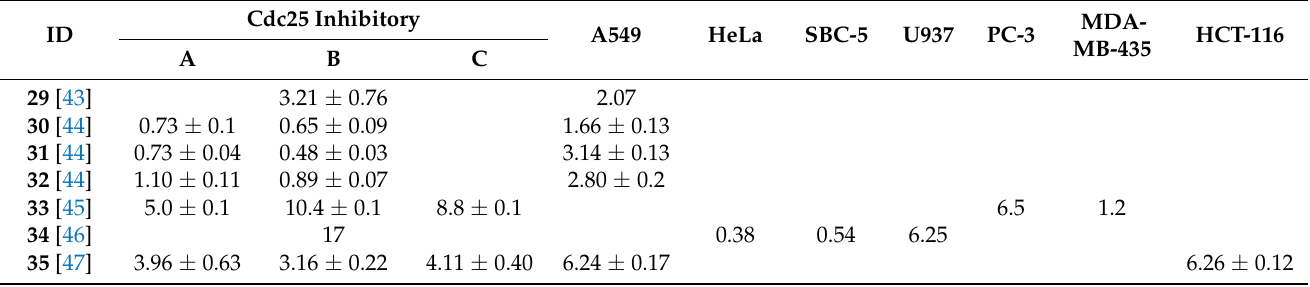
Figure 5. New quinone structures. Table 3. New quinoid structures based on tanshinone patterns as Cdc25